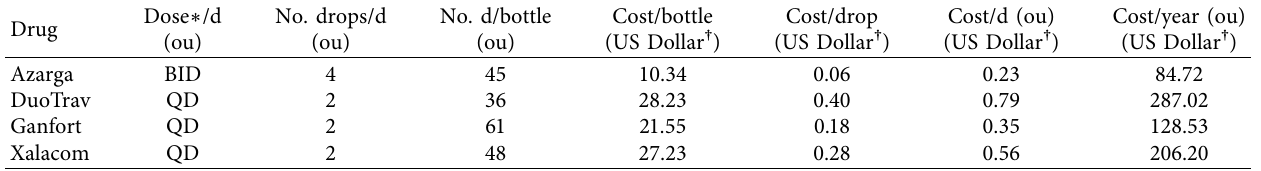
Table 2: The number of drops per day, the usage time per bottle, the price per bottle, the daily cost, and the yearly cost of glaucoma fixed combinations.